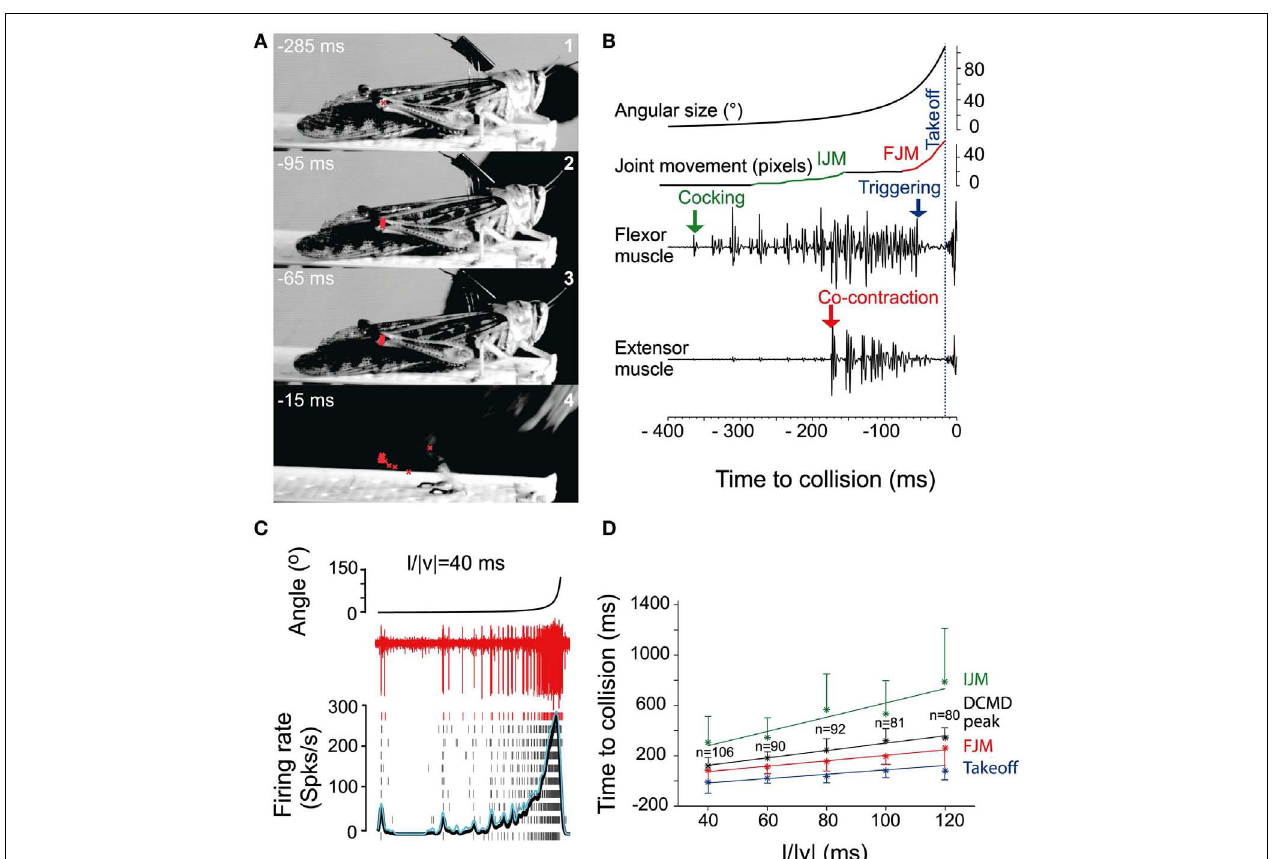
extracellularly in the nerve cord from one locust (red traces). Raster plots show DCMD spikes recorded in 10 repetitions of the stimulus. Black and blue traces show average DCMD firing rate and its standard deviation, respectively. (D) Timing of joint movements, DCMD peak and takeoff obtained from seven locusts.The DCMD peak occurred after the IJM and before the FJM and takeoff for all l /| v | values ( l /| v | = ratio of stimulus radius ( l ) to the velocity ( v ) of the stimulus). Adapted with permission from Fotowat and Gabbiani